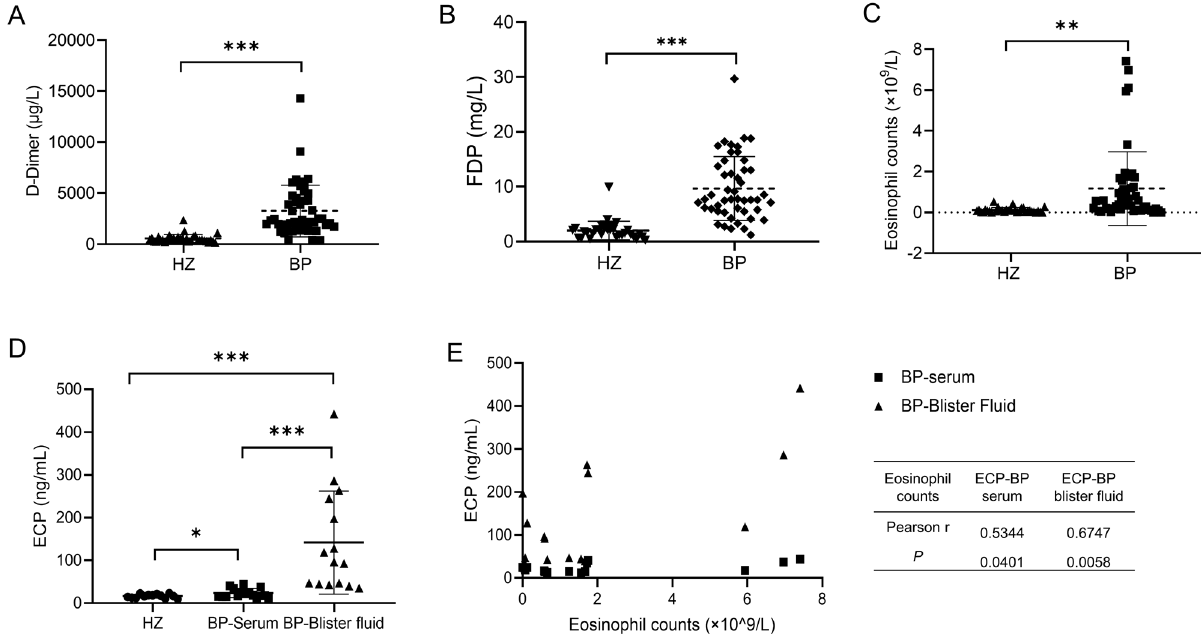
Figure 1. The levels of D-Dimer, FDP, and eosinophils in 48 BP patients and 33 HZ controls. ( A and B ) D-dimer and FDP levels were increased in BP patients compared to HZ controls; ( C ) Peripheral blood eosinophil counts in BP patients were higher than those in HZ controls; ( D ) Eosinophil cationic protein (ECP) expression was upregulated in BP serum and blister fluid than that in serum of HZ controls; ( E ) The correlation between eosinophil counts and serum/ blister fluid ECP levels. (* P < 0.05; ** P < 0.01; *** P < 0.001). The solid lines represent upper and lower quantile while a dotted line in the middle symbolizes